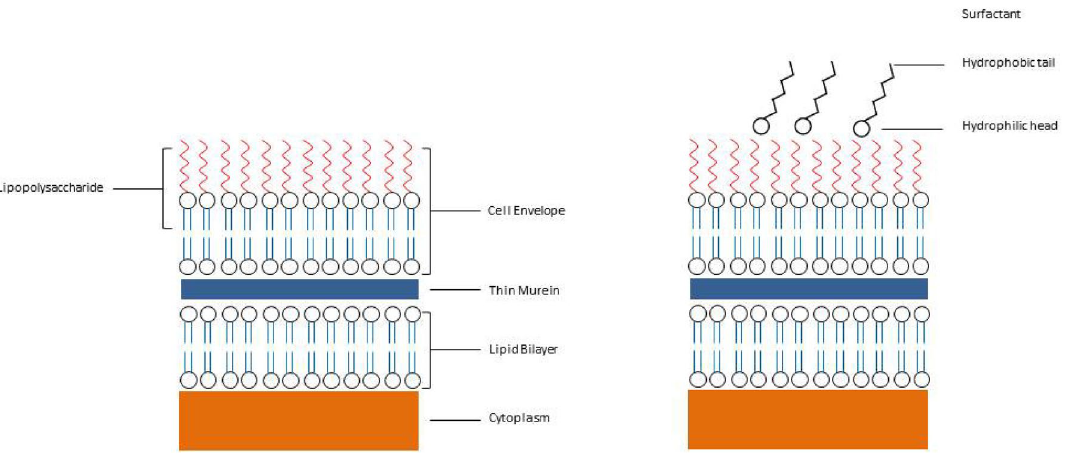
Fig. 4 Effect of surfactant on cell surface properties (left: without surfactant and right: with surfactant)